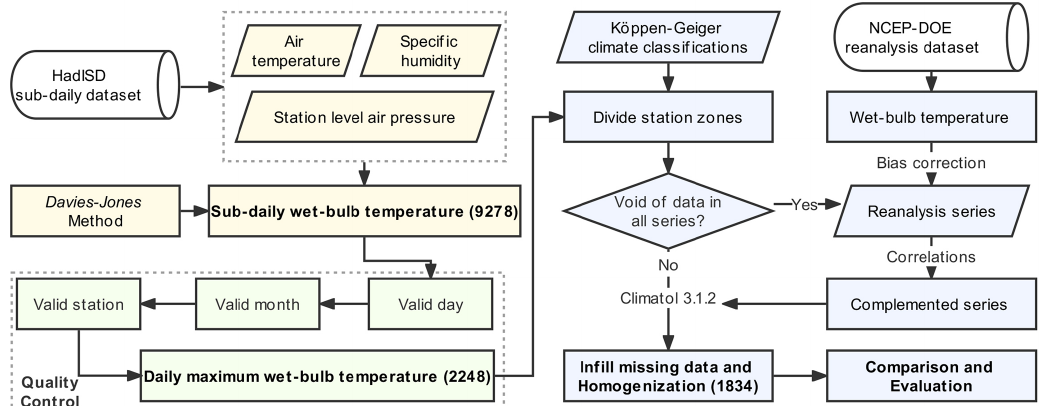
Figure 1. Procedures of producing the global station-based daily maximum wet-bulb temperature (GSDM-WBT) dataset. The numbers in the parentheses indicate the number of stations that remained after each